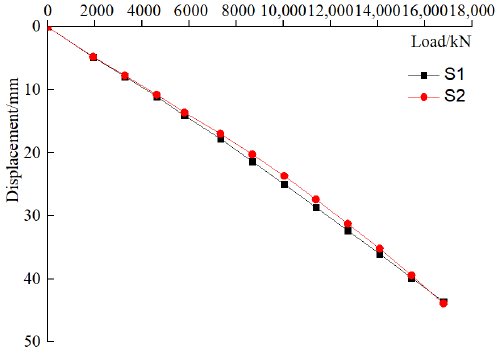
Figure 3. Self − balance curves of test piles: ( a ) S2 test pile and ( b ) S4 test pile.